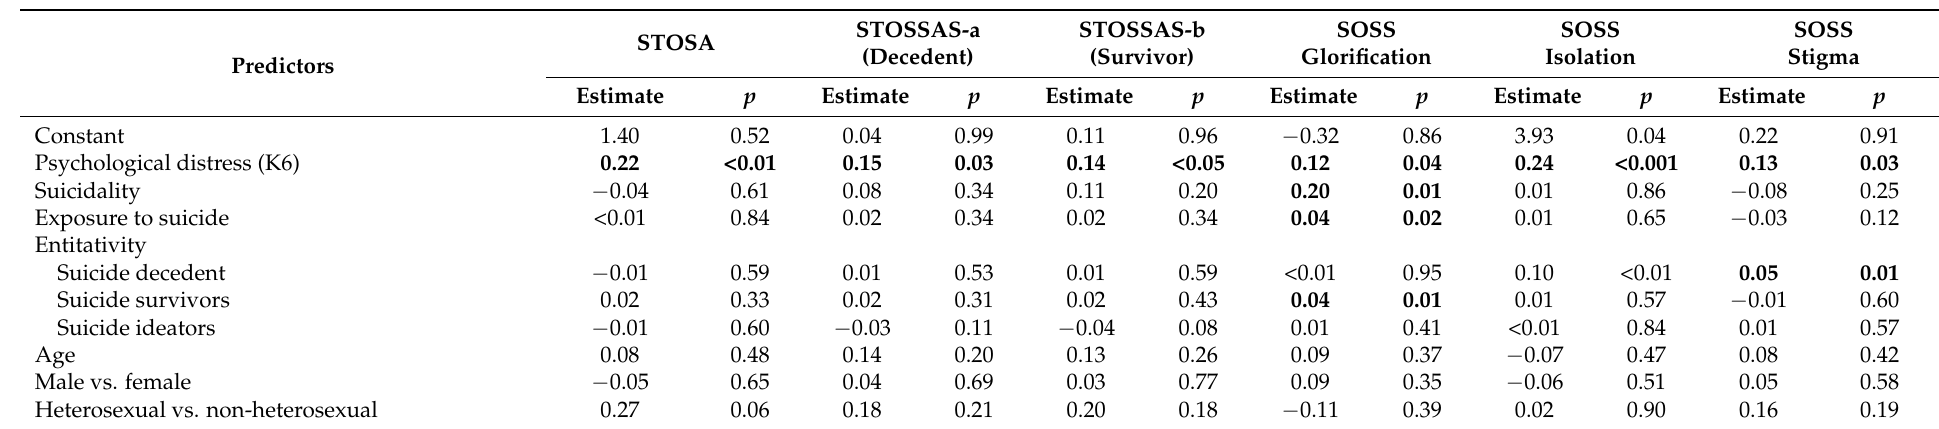
Table 4. Linear regression models for suicide stigma (N =